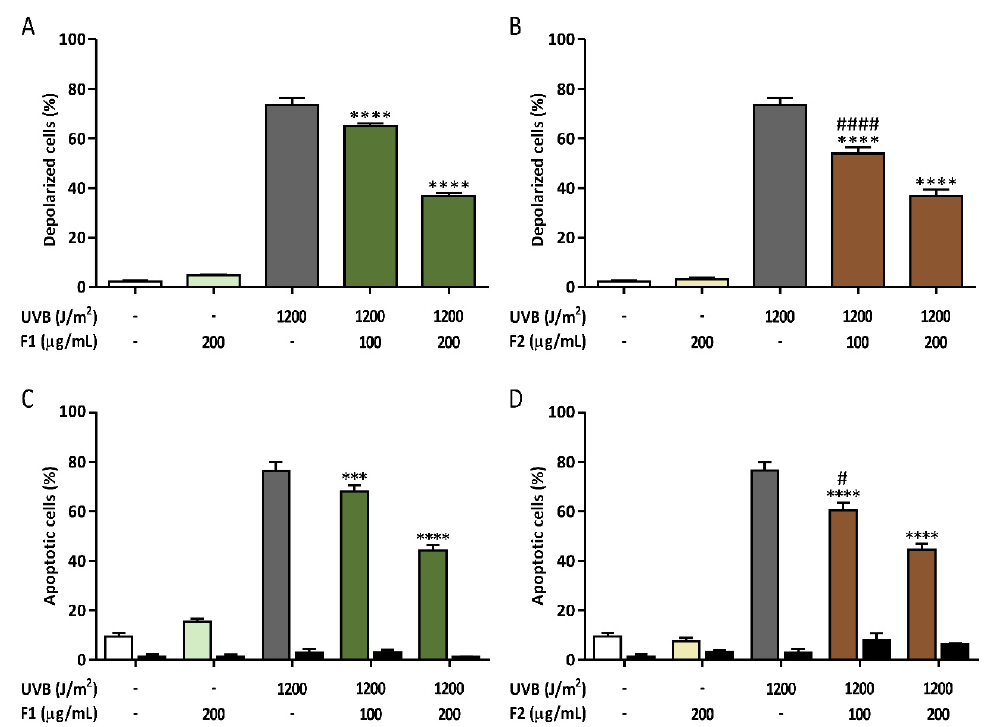
Figure 6. Reduction of UVB-induced mitochondrial depolarized HaCaT cells ( A , B ) and UVB-induced late apoptosis ( C , D ) by formulations F1 and F2. Black bars show early apoptosis. The data are expressed as the mean ± SD. *** ( p < 0.001) and **** ( p < 0.0001) indicate significant differences between irradiated and nontreated controls, while # ( p < 0.05) and #### ( p < 0.0001) indicate significant differences between irradiated cells treated with the other formulation at the same concentration. Representative population plots are included in the Supplementary information, Figure S1.